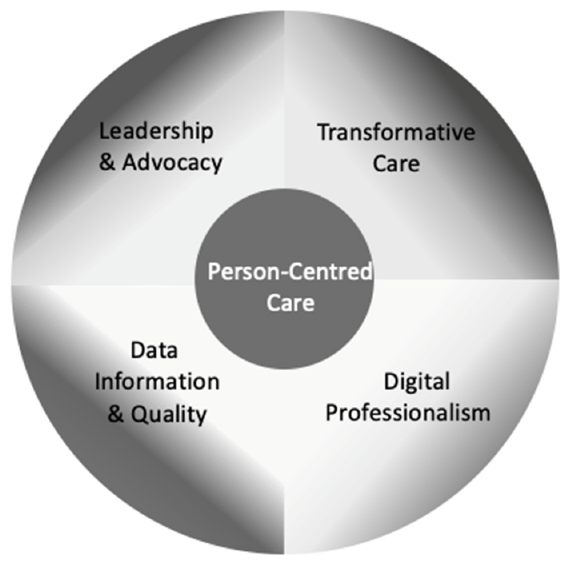
Figure 2. Quadrants of COMPASS theoretical framework and implementation model.